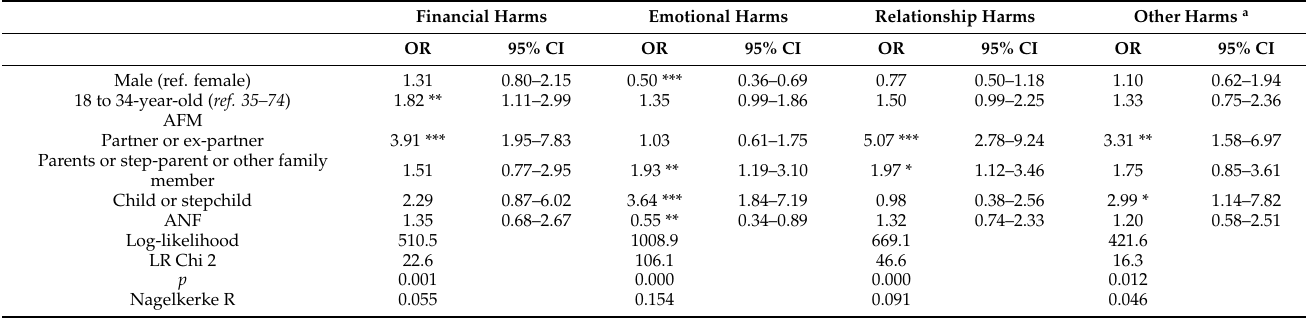
Table 4. Logistic regression models on the association between different harm categories and relationship to the